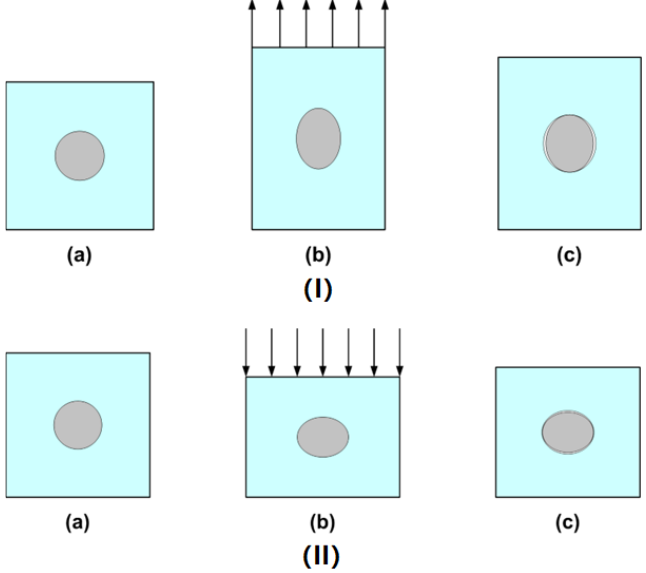
Figure 7. Illustration of structural change. ( a ) Original; ( b ) during programming; ( c ) after programming. ( I ) Programmed via tension. ( II ) Programmed via compression. ming. ( I ) Programmed via tension. ( II ) Programmed via